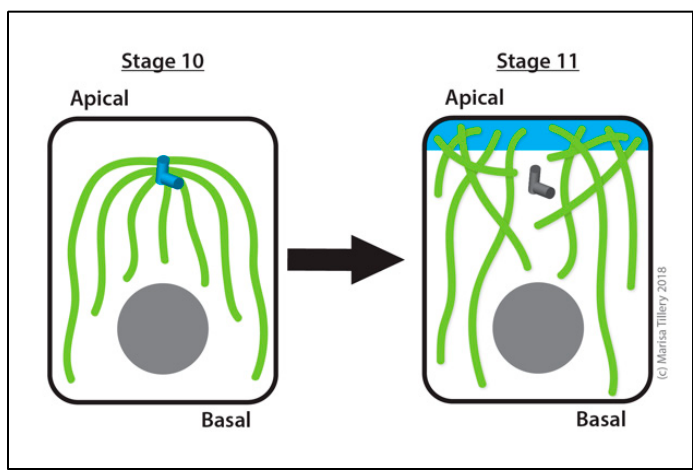
Figure 9. An apical membrane ncMTOC assembles in tracheal epithelia. The MTOC is blue and transitions from the centrosome to an apical ncMTOC; MTs are green; the nucleus is